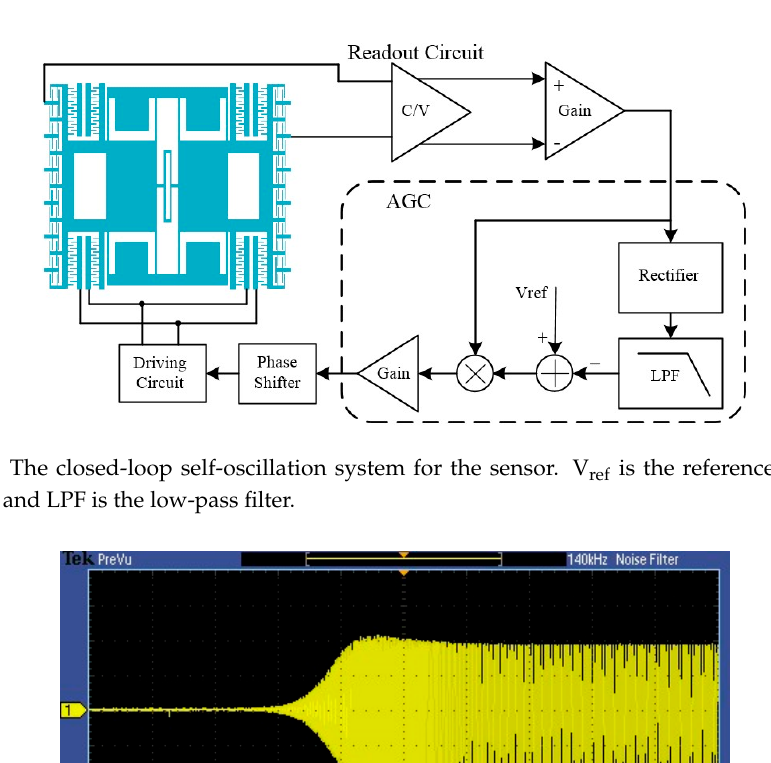
Figure 9. The resonance characteristics of the sensor.